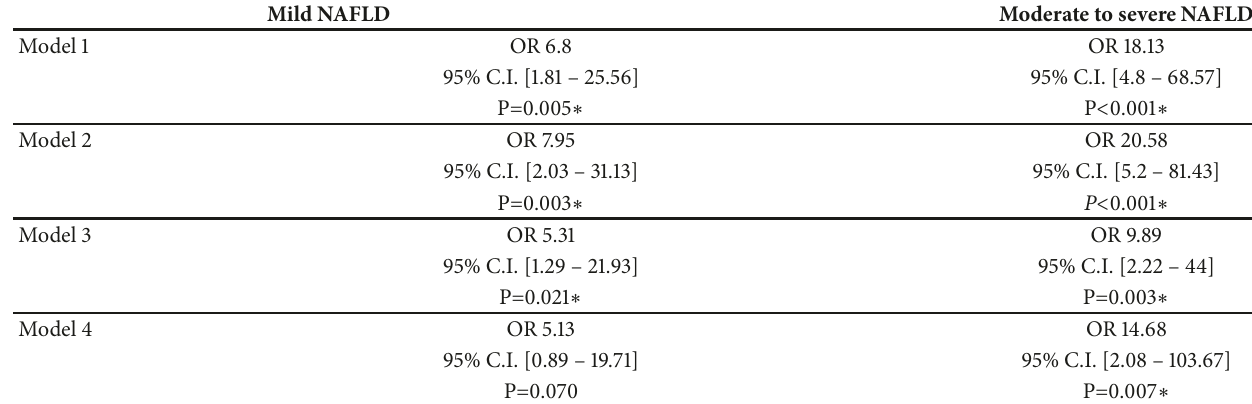
Table 3: Odds ratios (ORs) for metabolic syndrome regarding degree of NAFLD.